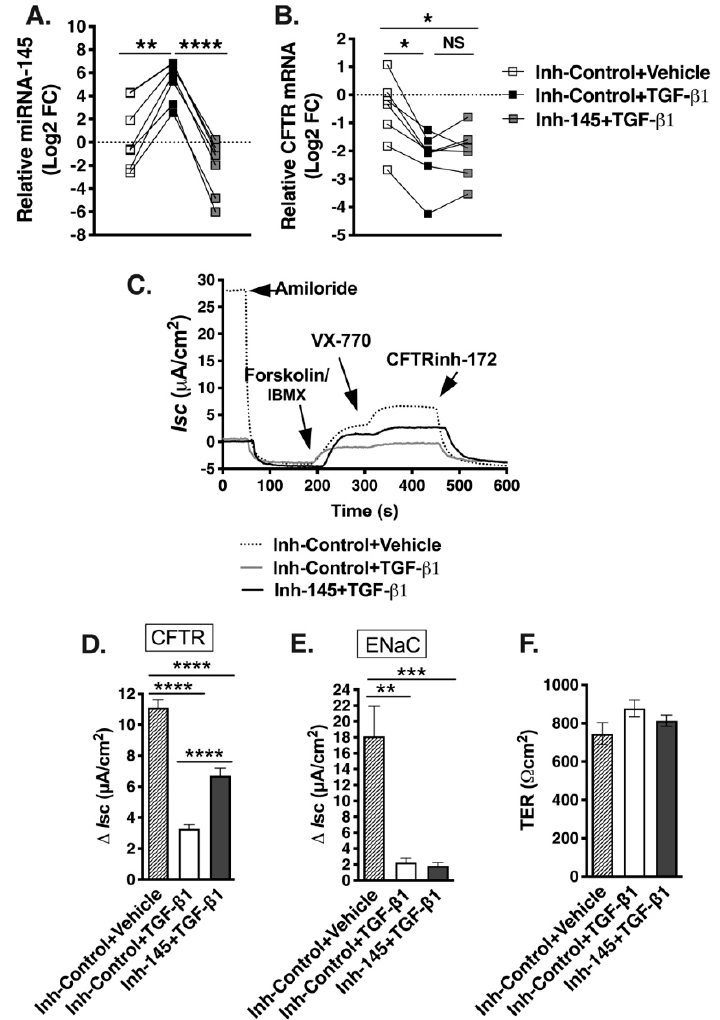
Figure 7. Anti-miR-145 oligonucleotide completely blocked TGF- β 1 upregulation of miR-145 but only partially reversed repression of CFTR mRNA, allowing partial rescue of CFTR Isc in select F508del HBE cells. F508del HBE cells were treated with miRCURY LNA ™ Power Inhibitor hsa-miR-145-5p (Inh-145) or miRCURY LNA ™ Inhibitor control (Inh-Control) for 8 days, correctors C18 and C002 for 48 h, and with either TGF- β 1 or vehicle for 24 h before the experiments. ( A ). qRT-PCR experiments demonstrating that Inh-145 blocked the TGF- β 1-induced upregulation of miR-145 expression in all examined HBE cells. Expression of miR-145 was normalized to U6 snRNA and expressed as Log2 FC relative to Inh-Control and vehicle-treated cells. ( B ). qRT-PCR experiments demonstrating that Inh- 145 partially blocked the TGF- β 1 repression of F508del-CFTR mRNA in four out of seven examined HBE cell lines. Expression of CFTR mRNA was normalized to GAPDH mRNA and expressed as Log2 FC relative to Inh-Control and vehicle-treated cells. Representative Ussing chamber recordings ( C ) and summary of data ( D ) showing that Inh-145 partially blocked the TGF- β 1 inhibition of corrector rescued CFTR-mediated Isc in those F508del HBE cells in which Inh-145 partially blocked repression of CFTR mRNA. ( E ). Inh-145 did not affect the TGF- β 1 inhibition of ENaC-mediated Isc. (F). The experimental conditions did not change the trans-epithelial resistance (TER) across F508del HBE cell monolayers. N = 7 in triplicates in F508del HBE cells from seven different donors ( A , B ). Eight monolayers/group from two lung donors ( C – F ). Error bars, S.E.M. * p < 0.05; ** p < 0.01; *** p < 0.001; **** p < 0.0001.